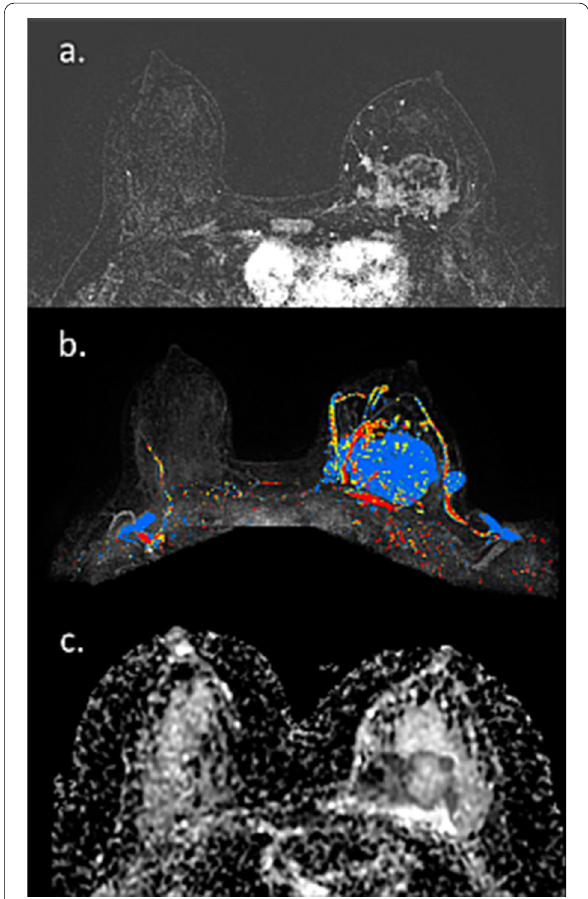
subtraction DCE‑MRI, CAD and ADC map of a lactating patient with a 7 cm IDC on the right breast are presented. The huge lesion exhibited vivid enhancement as compared to the mild BPE ( a ), with heterogeneous kinetic features ( b ) and decreased ADC values as compared with the surrounding parenchymal diffusivity ( c